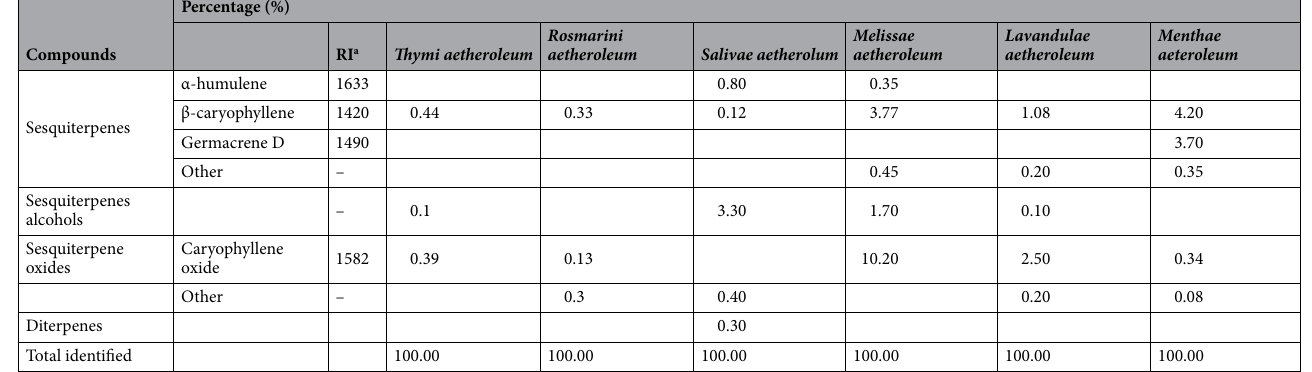
Table 1. Chemical composition of selected essential oils. a Retention index calculated relative to elution time of C9-C24 n-alkane from HP 5MS